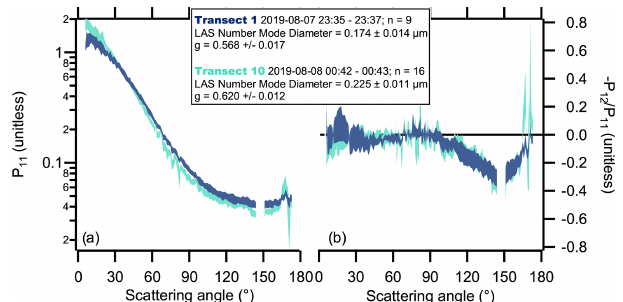
Figure 7. Angularly resolved radiance and polarimetry measure- ments of wildfire smoke. Panel (a) shows the phase function ( P 11 ), and panel (b) shows the degree of linear polarization (DoLP, − P 12 /P 11